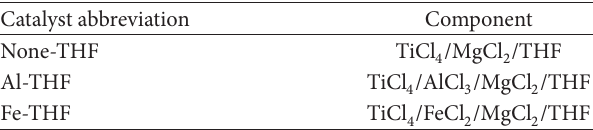
Table 1: Abbreviation of the prepared